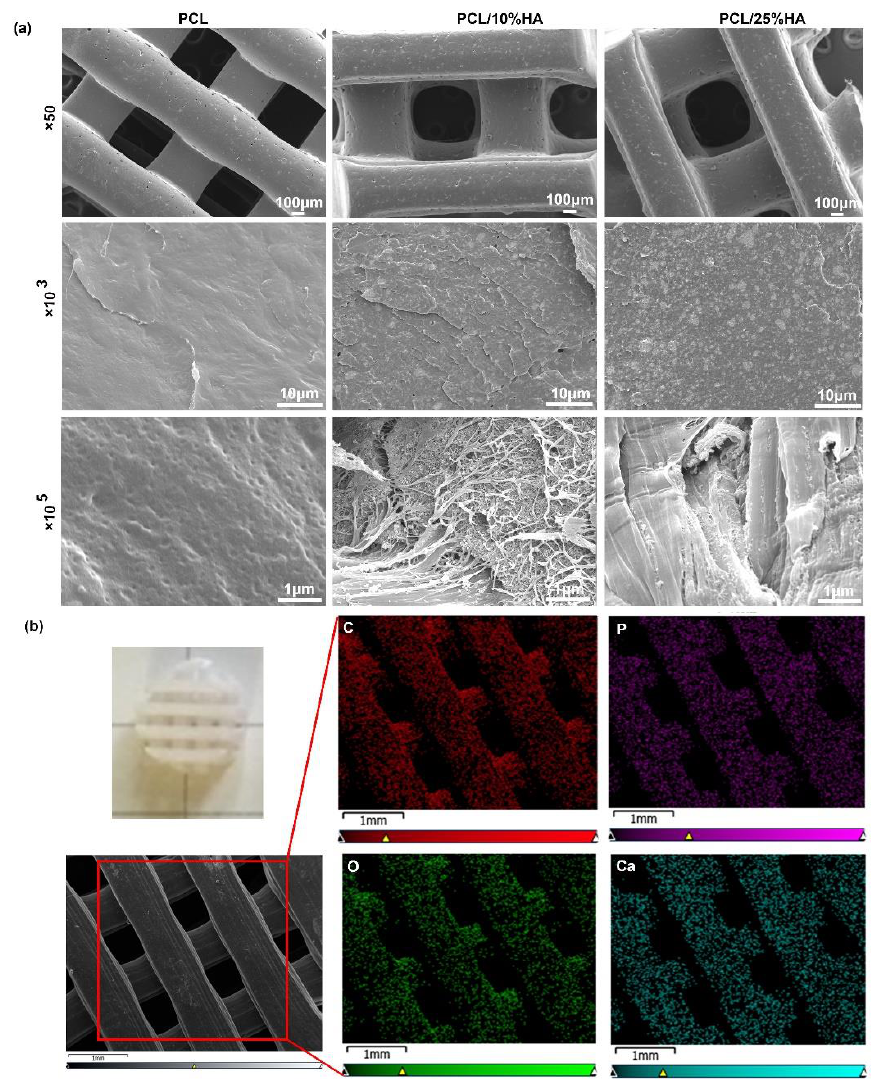
Figure 1. The characteristics of scaffolds. ( a ) Micromorphology of PCL/HA scaffolds in different content (0%, 10%, 25%) (upper panel: × 50, middle panel: × 10 3 , lower panel: × 10 5 ); ( b ) The optical graphs and EDS mapping distribution of C, O, Ca, and P elements in the surface of PCL/25% HA